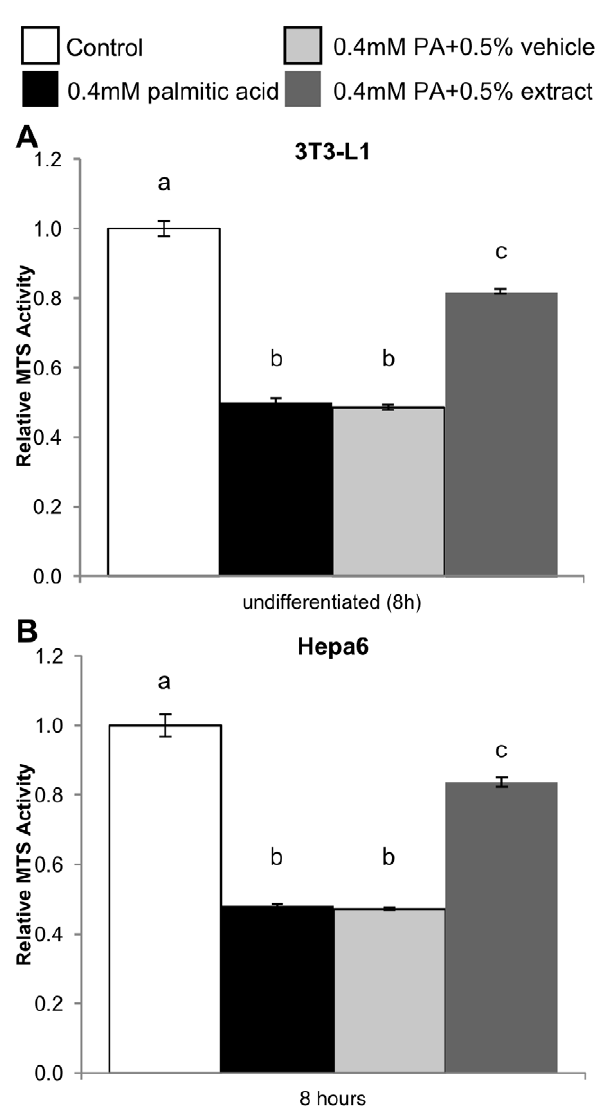
Figure 2. Protective effect of BEX on palmitic acid (PA)-induced lipotoxicity. 3T3-L1 (A), and Hepa6 cells (B) were grown to confluency in 96-well plates and treated with 0.4 mM PA for 24 hours in combination with BEX (125 m g/ml or 0.5%, v/v) or ethanol (0.5%, v/v) as a solvent control. Cell viability was measured using a MTS assay. Mean 6 standard deviation over 5 trials, n $ 3 wells per trial. Differences between means are statistically significant if the columns do not share any common letters (p , 0.001, one-way ANOVA, Tukey’s multiple comparison test).